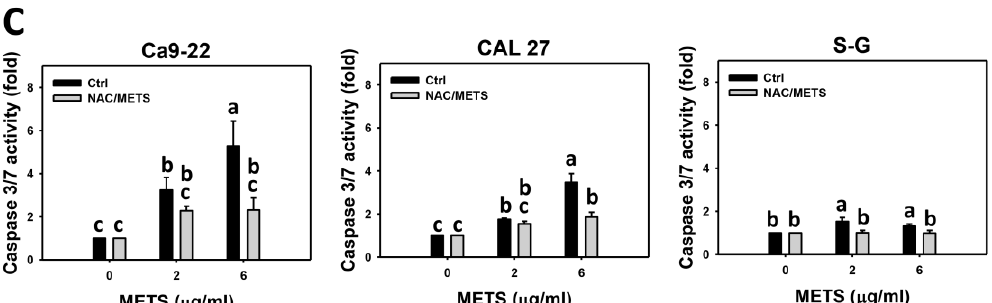
Figure 5. METS leads to caspase 3 and 3/7 activations in oral cancer cells. ( A ) Caspase 3 histogram changes. Cells were treated with METS for 24 h. Oral cancer and normal cells (S-G) were included. (+) indicates a high intensity of caspase 3. ( B , C ). NAC response on caspase 3 and 3/7 activations. For caspase 3 assay, untreated control and NAC pretreatment were followed by posttreatment of vehicle control and METS (6 µ g/mL) for 0, 12, and 24 h, i.e., control, NAC, METS, and NAC/METS, respectively. Except for 24 h, other conditions of caspase 3/7 assays were the same as caspase 3 assay. Data = mean ± SD ( n = 3). Data showing non-overlapping lower-case letters have significant results ( p < 0.05) as analyzed by the one-way ANOVA analysis and post hoc test.